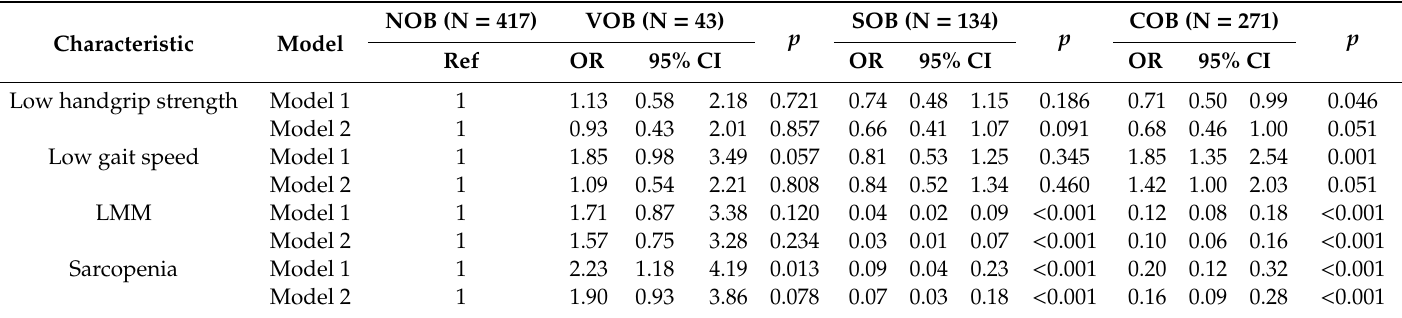
Table 3. Odds ratios (95% confidence intervals) for sarcopenia and its components according to high BMI and high VFA.